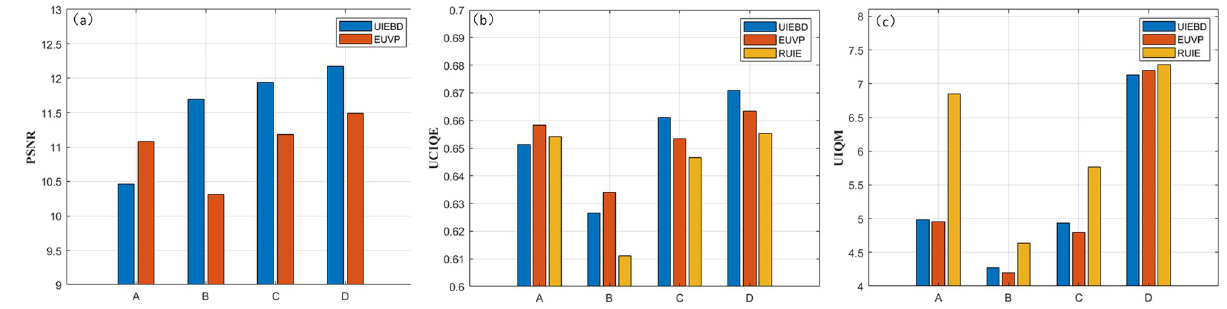
Fig 12. PSNR, UCIQE and UIQM value of ablation experiment. (a) PSNR; (b) UCIQE; (c) UIQM.